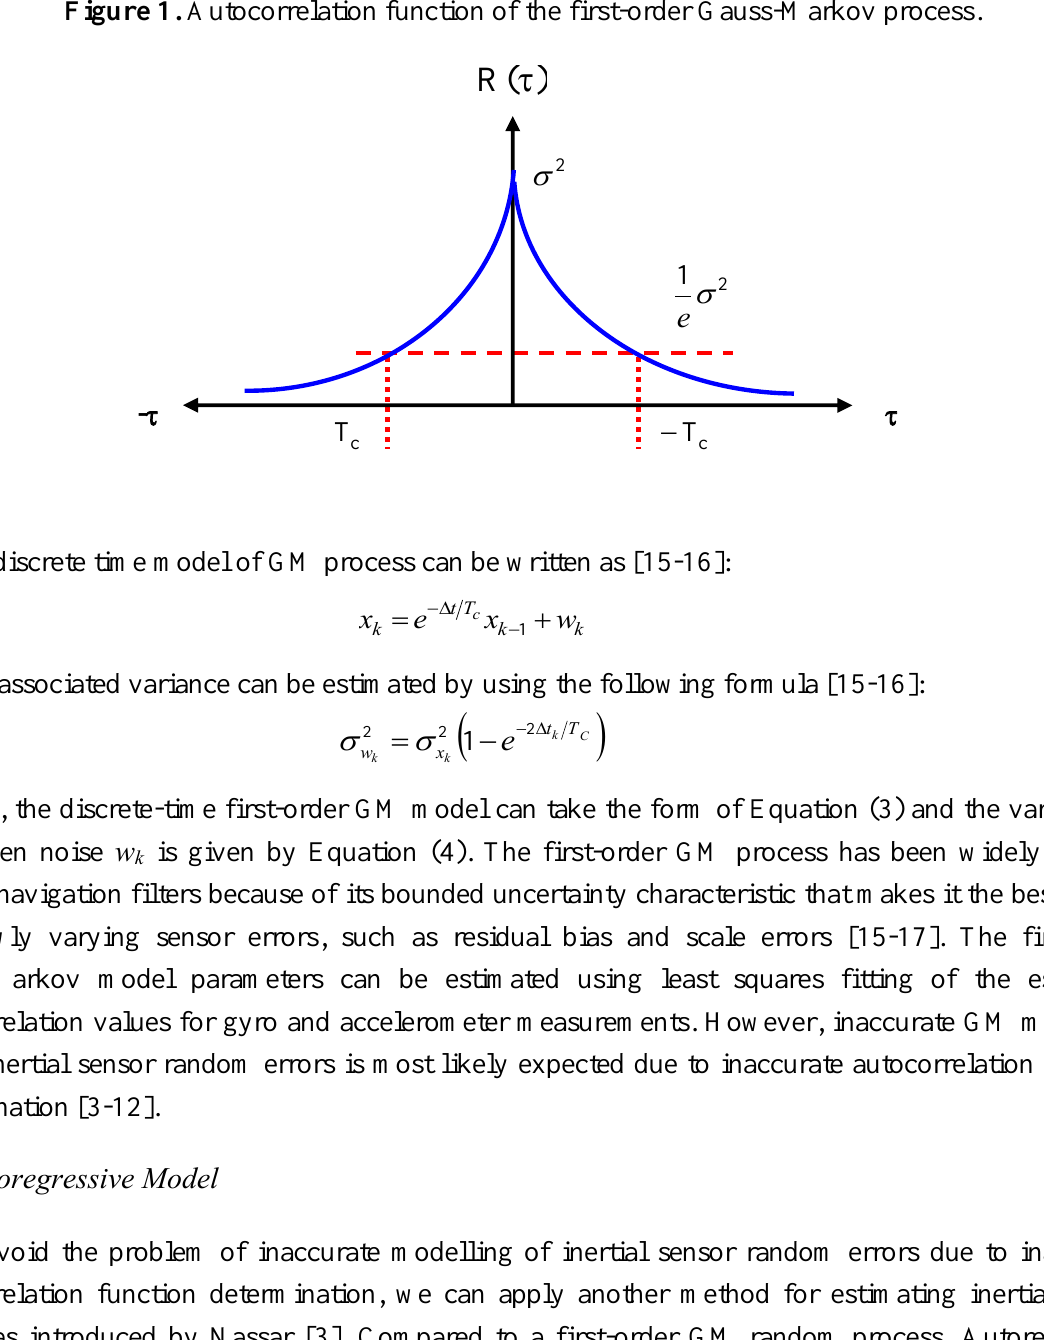
Figure 1. Autocorrelation function of the first-order Gauss-Markov